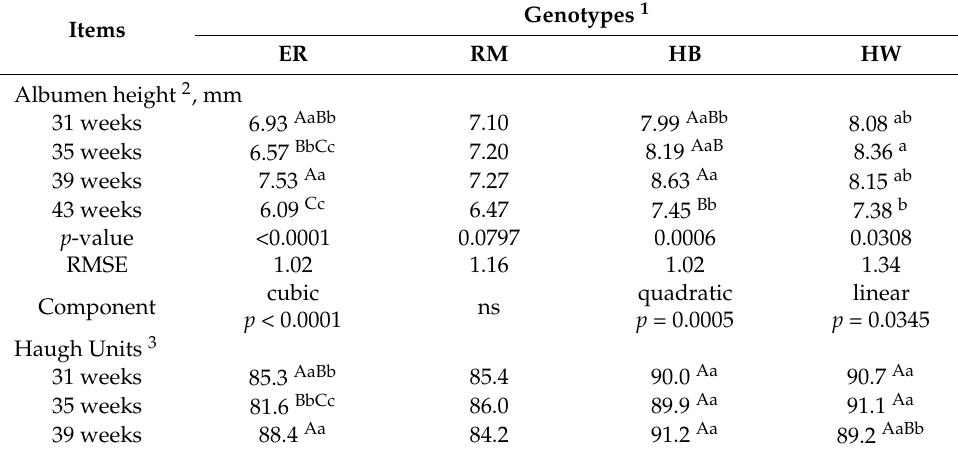
Table 3. Effect of age on albumen height and Haugh Units of 1 d egg according to the genotype of the